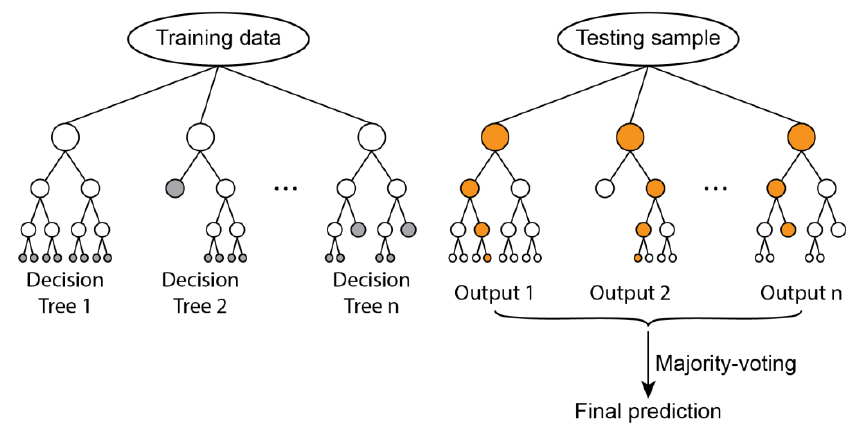
Figure 7. The structure of random forest model used in this article.